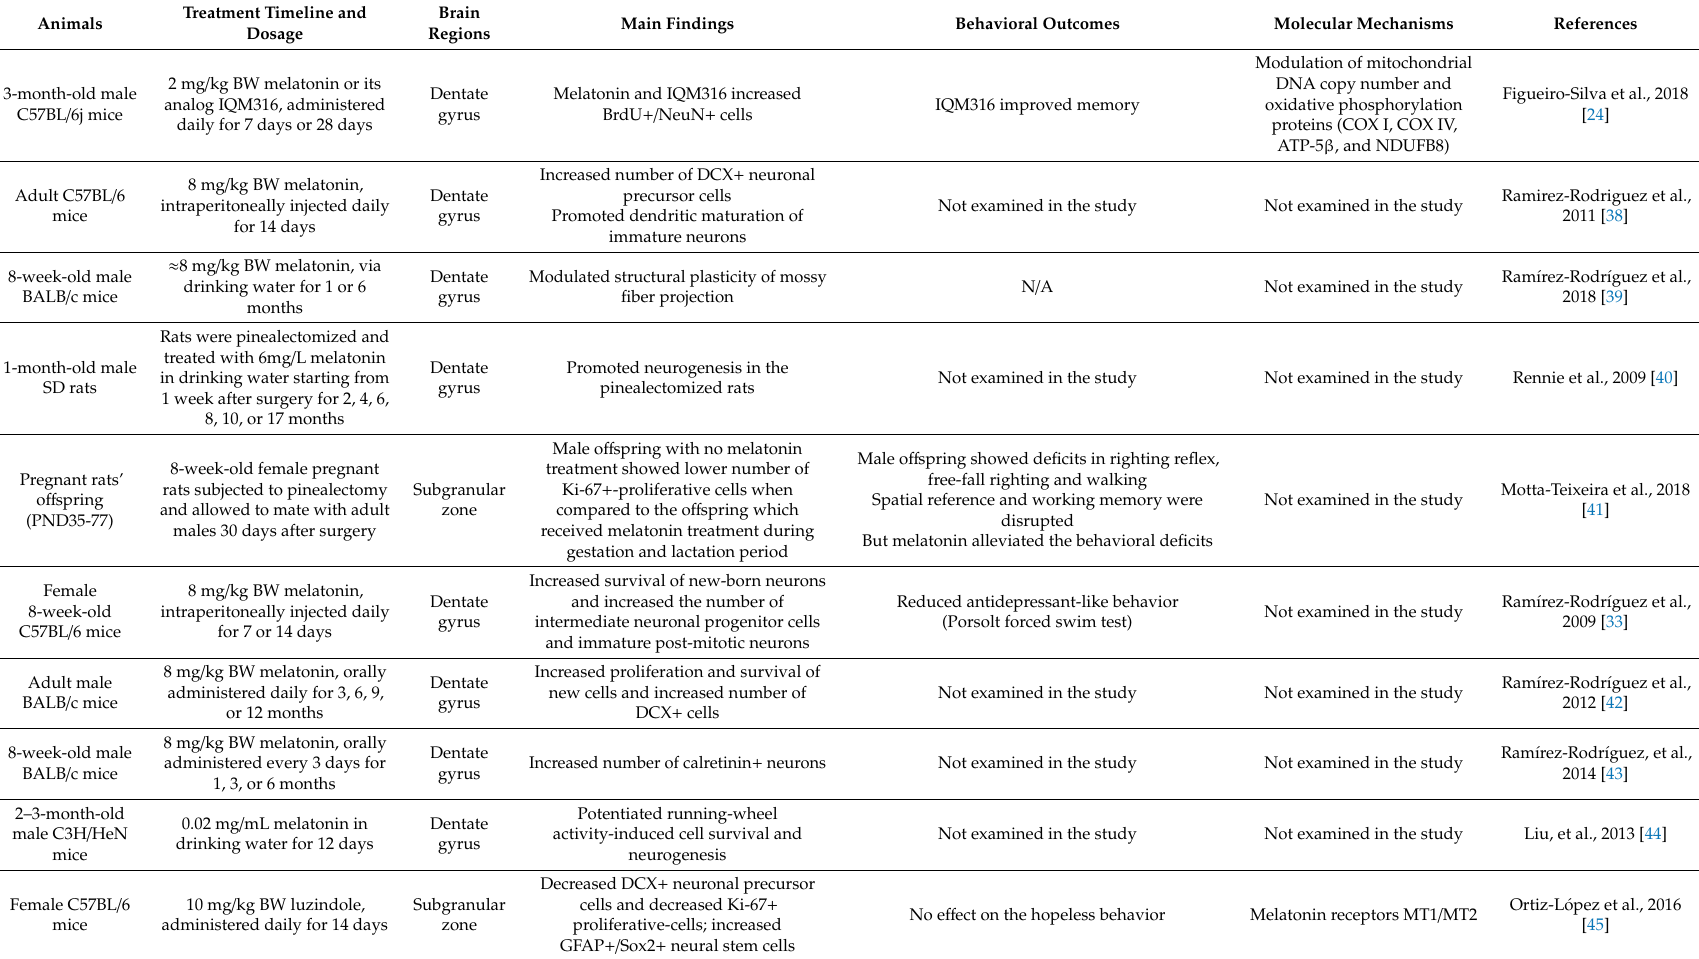
Table 2. Table showing the main findings regarding the e ff ects of melatonin or its analog(s) / receptor antagonist on neurogenesis and the respective molecular mechanisms in the in vivo